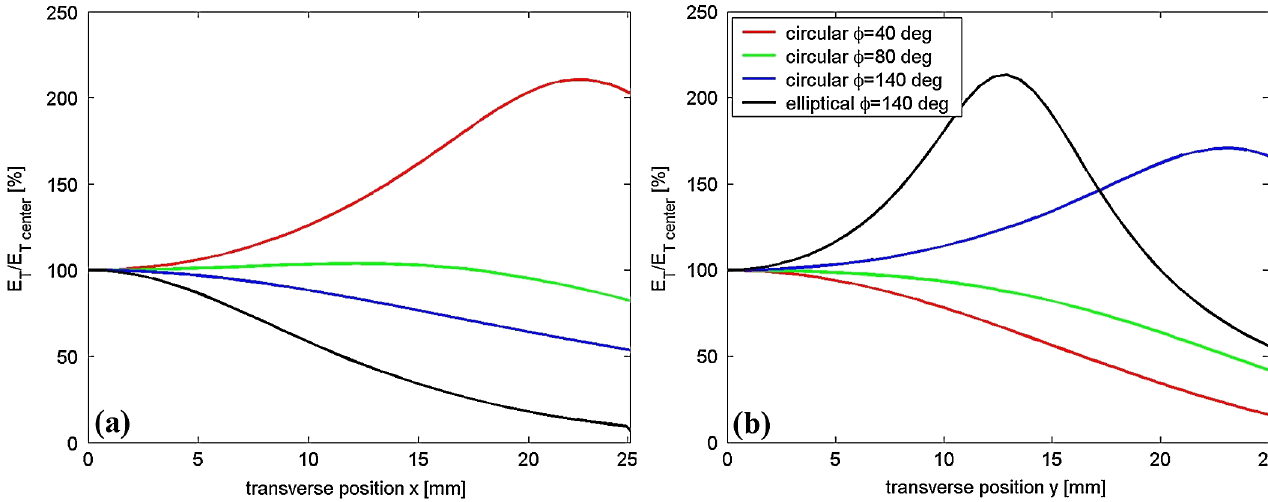
FIG. 4. Deflecting field normalized to its value at the center of the pipe, as a function of the transverse coordinates: (a) horizontal ( x ); (b) vertical ( y